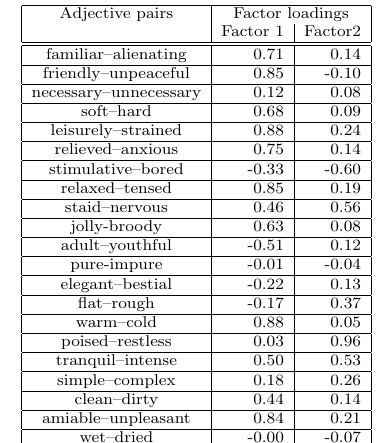
Table 2: Results for three factorial ANOVA.